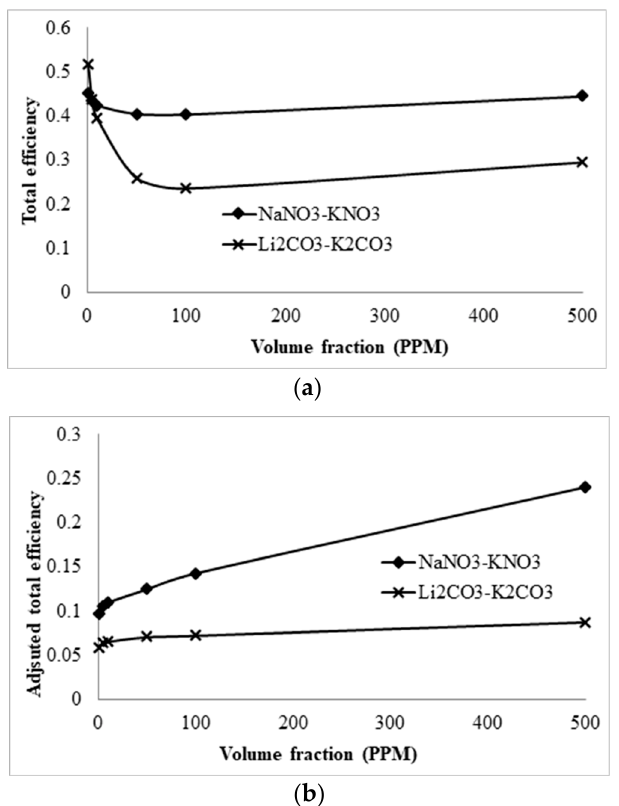
Figure 21. Comparison of the ( a ) total efficiency and ( b ) adjusted total efficiency between NaNO 3 –KNO 3 and LiCO 3 –K 2 CO 3 molten salt nanofluids.